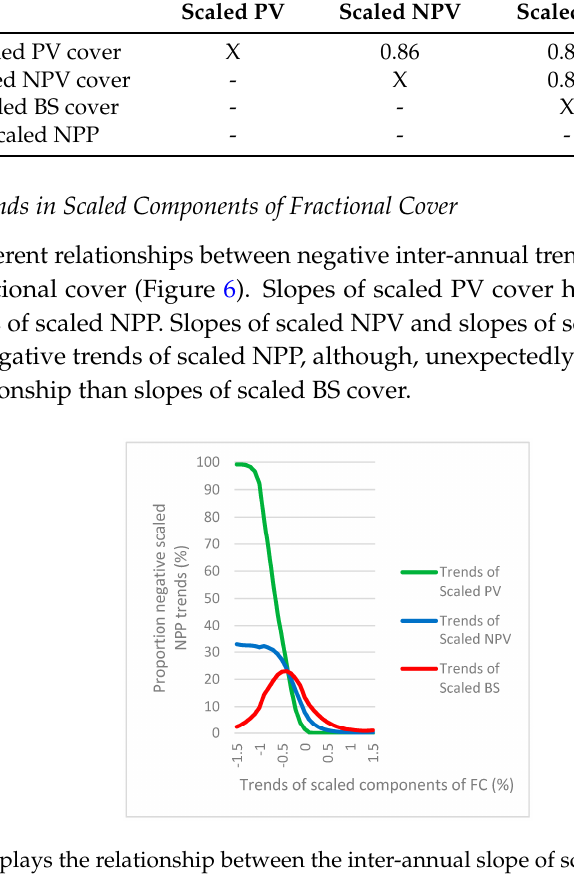
Figure 6. Plot displays the relationship between the inter-annual slope of scaled fractional cover and the proportion of significant, negative trends of scaled NPP, for each component of fractional cover: photosynthetic vegetation (PV), non-photosynthetic vegetation (NPV), and bare soil (BS).